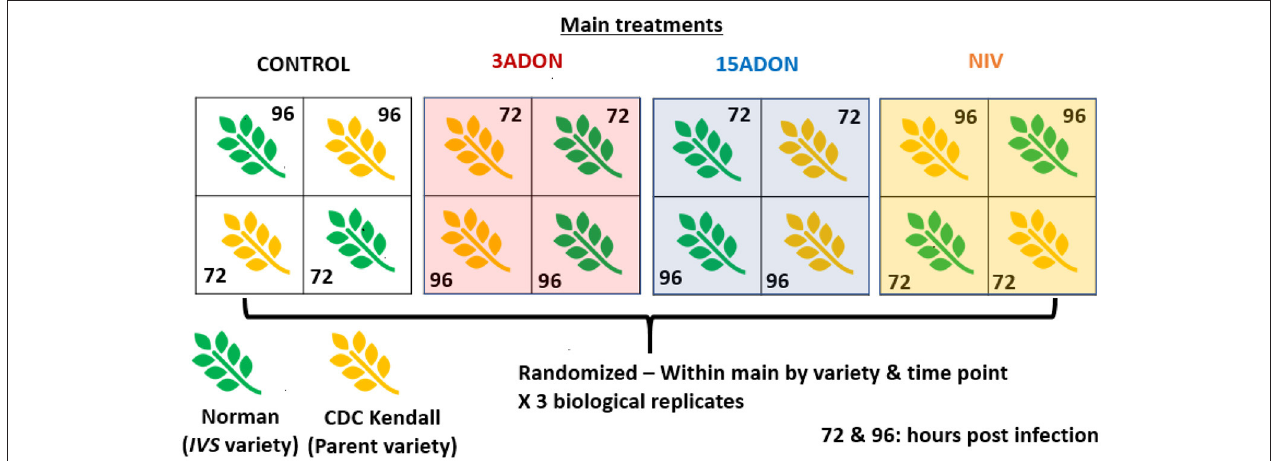
FIGURE 1 | Split-plot experimental design. Main plot treatments: Control, mock control; 3ADON, 3-acetyldeoxynivalenol producer; 15ADON, 15-acetyldeoxynivalenol producer; NIV, nivalenol producer. Genotype (Norman or CDC Kendall) and sampling time point (72- and 96-h post infection) were randomized within the main